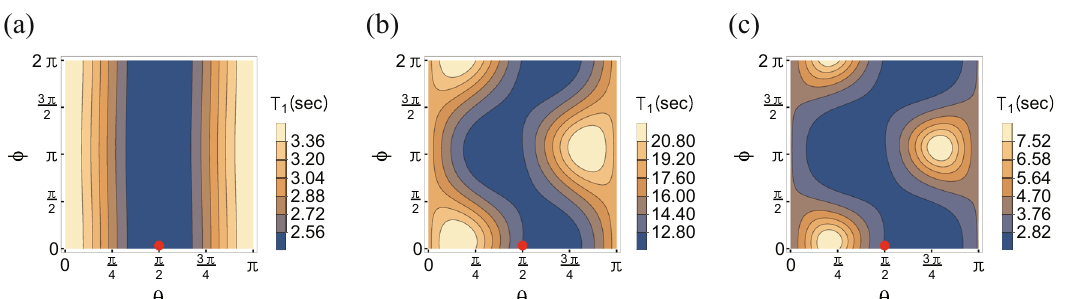
Fig. 3 The anisotropy maps of relaxation time T 1 . x and y axes are the polar angle θ and the azimuthal angle ϕ with respect to the device's z - direction, respectively. The conductivity of gates are a σ = 2 × 10 8 S/m, b σ = 2 × 10 7 S/m, and c σ = 2 × 10 6 S/m. The applied fi eld direction ( θ , ϕ ) = ( π /2, 0) used in the experiment is indicated by red dot.